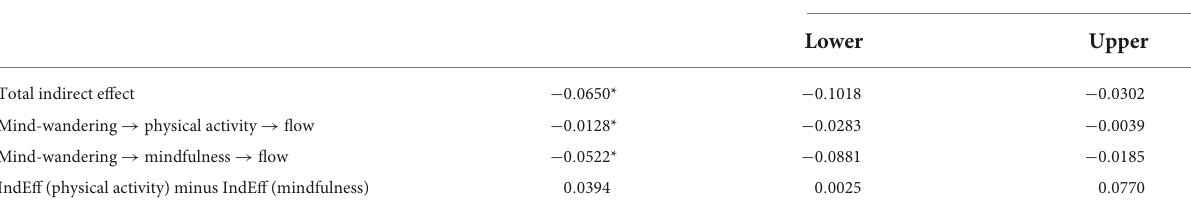
TABLE 3 Indirect effects and 95% CIs. Model